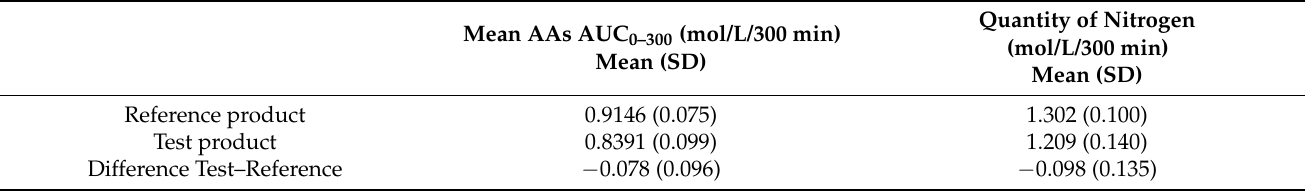
Table 4. Comparison of total plasma amino acids AUC 0–300 and related quantity of nitrogen after administration of the Test and Reference product.